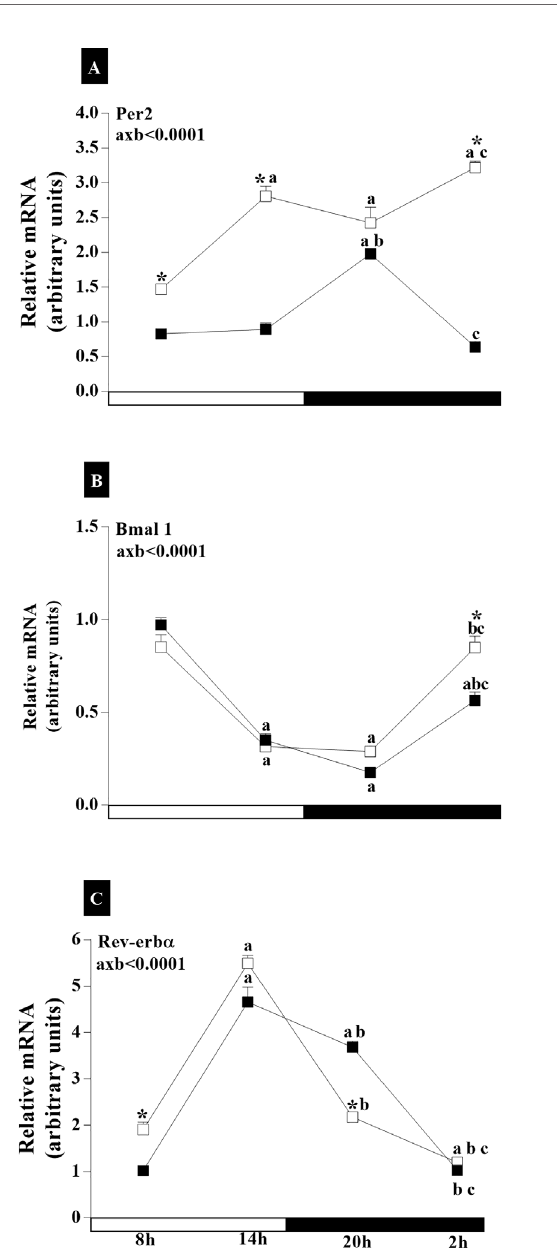
FIGURE 7 | Daily oscillations in relative mRNA expression for Per2 , Bmal1 , and Rev-erb a in the adenohypophysis. Light and dark phases are represented along the X-axis by their respective schedules. Beginning of the light phase at 07:00, when the lights are turned on. The dark phase started at 19:00. All samples were collected at six-hour intervals after the fi rst hour (i.e., 08:00), for 24 h. Light/dark cycle = 12/12 h. (A) Relative temporal expression of mRNA for Per2 , (B) Bmal1 , and (C) Rev-erb a in animals with a regular cycle on diestrus day and irregular cycle in persistent diestrus. * indicates intergroup variation at the same time: ( ■ ) Regular estrous cycle on diestrus day × ( □ ) Irregular cycle in persistent diestrus. Letters indicate temporal variation within the group. a vs. 08:00; b vs. 14:00; and c vs. 20:00. axb = age and time of day interaction. n = 3 – 7. Replicates with a variation above 0.2 were automatically excluded from the groups. DD Ct for Per2 and Rev-erb a ; relative standard curve for Bmal1 .